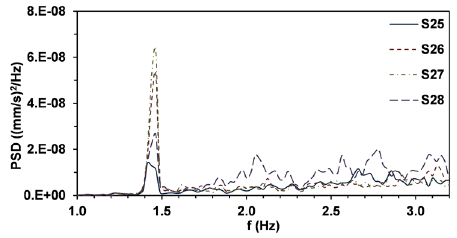
Figure 18. PSDs of S25-S28 in configuration